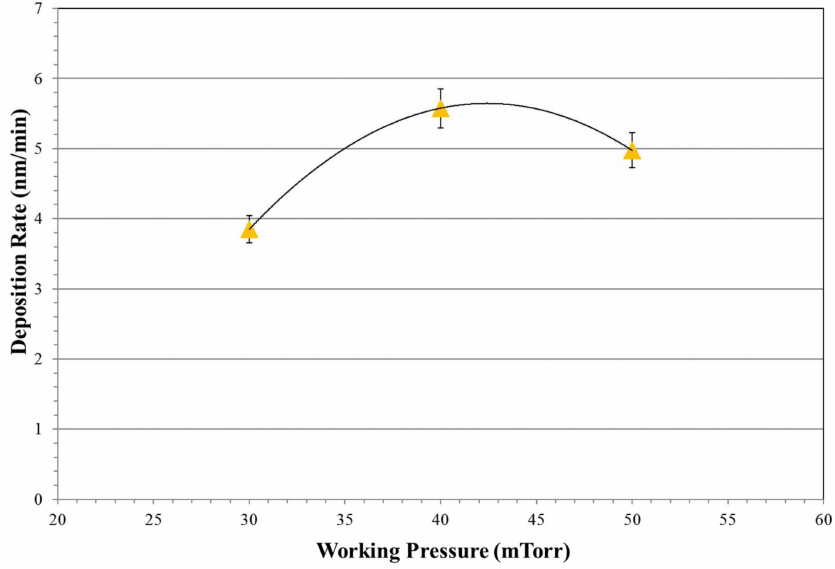
Figure 8. Deposition rates as a function of working pressure.